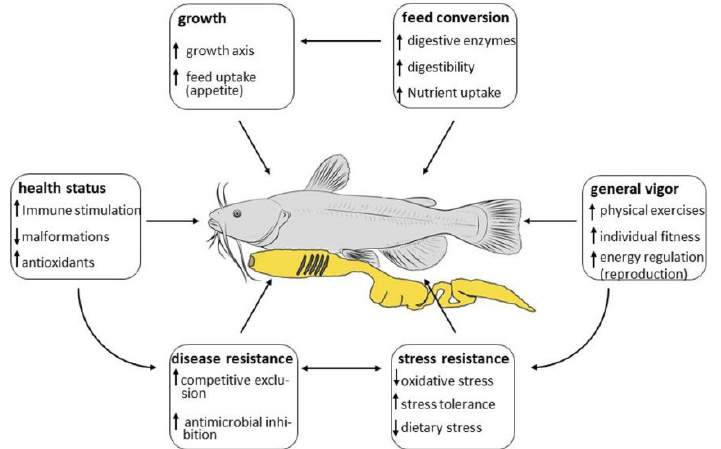
Figure 1. Mode of action of probiotics, including increased growth performance and appetite, enhanced feed conversion (e.g., by secretion of microbial digestive enzymes) or improved feed value (macro- and micronutrients), increased stress tolerance, improved disease resistance due to the inhibition of pathogenic microorganisms (adherence and colonization), improved health status by stimulating the fish’s immune system, and enhancement of general vigor.